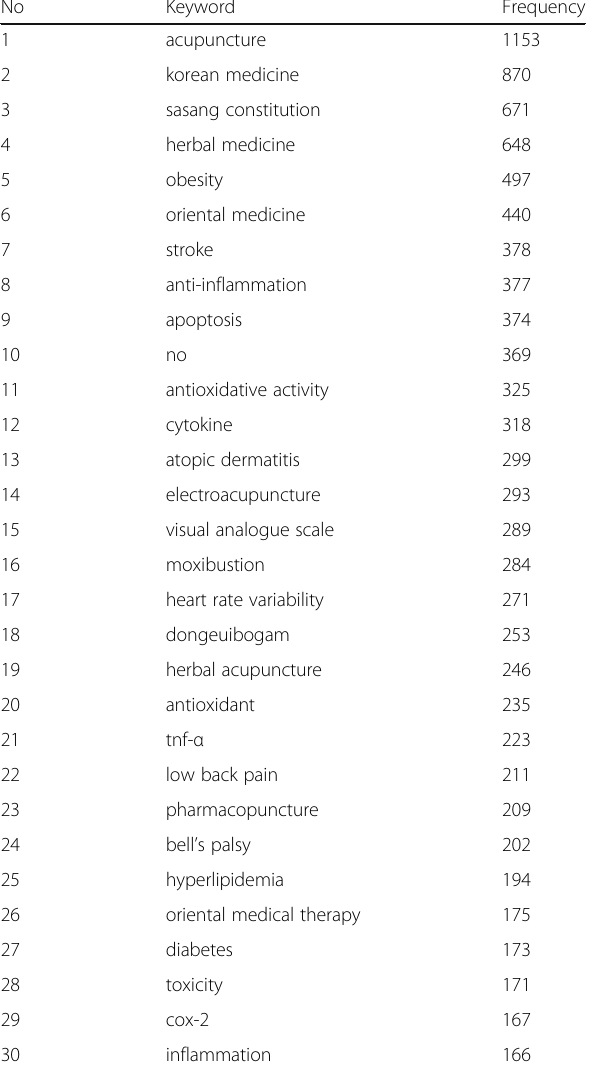
Table 1 List of the frequencies of the keywords in OASIS. Abbreviations: cox-2 (cyclooxygenase-2); no (nitric oxide); tnf-